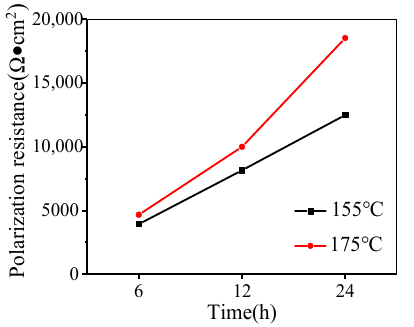
Figure 4. Polarization resistance (R p ) under different aging conditions.